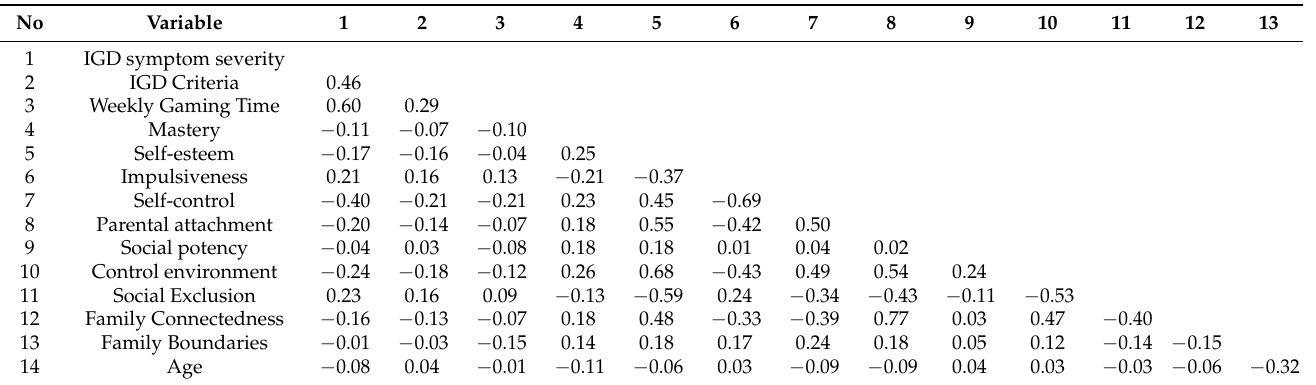
Table A1. Correlation